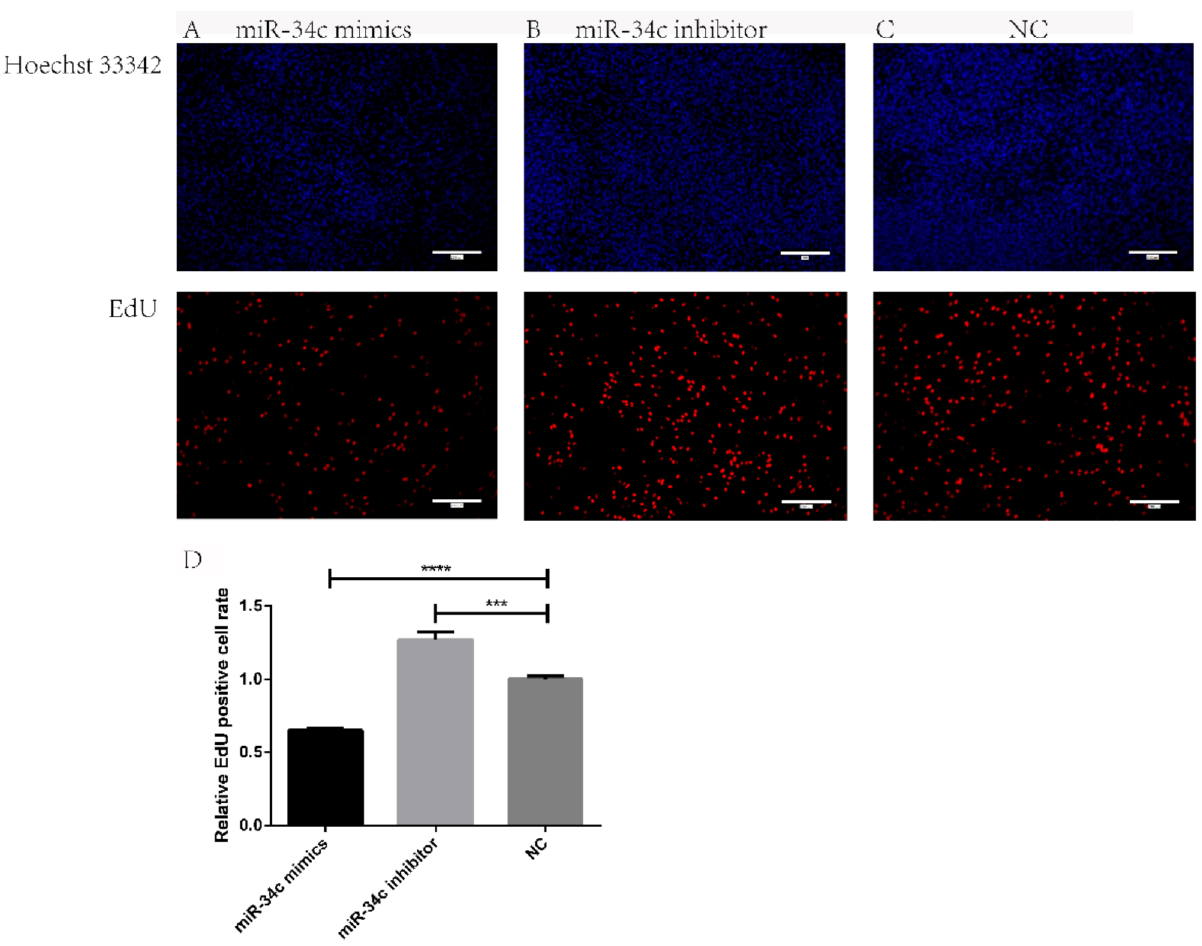
Figure 2. MiR-34c inhibits the proliferation of bovine Sertoli cells. ( A – C ) EdU and Hoechst 33342 staining of Sertoli cells. ( D ) Ralative EdU positive cell rate. The EdU-positive cells in bovine Sertoli cells after transfection and cell nuclei were counterstained with Hoechst 33342 (100 × ), Scale bar = 200 µ m. Data were presented as means ± SEM. Standard Error of Mean (SEM) was indicated by error bars. p < 0.05 was considered to be statistically significant. *** p < 0.001; **** p <